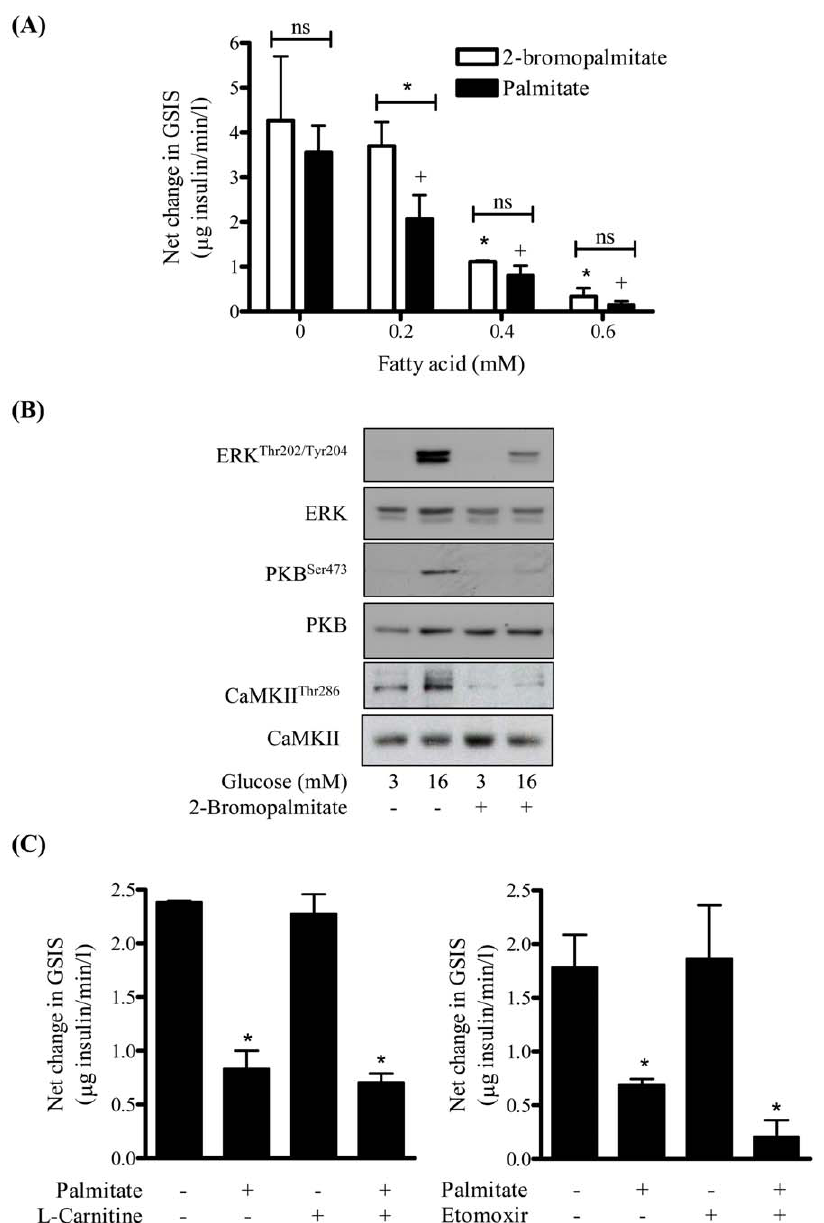
Figure 7. The repressive effects of palmitate on glucose-stimulated insulin secretion, PKB and ERK activation are not dependent upon fatty acid oxidation. (A) MIN6 b cells were incubated with varying concentrations of palmitate and 2-bromopalmitate (48 h) as indicated. Glucose (16 mM) was added for 1 h during serum starvation and the net change in glucose-stimulated insulin secretion assessed. (B) Cells were incubated in the absence or presence of 0.4 mM 2-bromopalmitate for 48 h and with glucose at the indicated concentration for 1 h. Cells were lysed and lysates immunoblotted for analysis of ERK Thr202/Tyr204 , PKB Ser473 , CaMKII Thr286 and total PKB, ERK and CaMKII. (C) Cells were incubated in the absence or presence of palmitate (0.4 mM) for 48 h and then after serum starvation cells were exposed to either L-carnitine (1 mM) or etomoxir (0.2 mM) for 2 h as indicated. Glucose (16 mM) was added during the final hour to induce GSIS and media removed for analysis of insulin content. Bars represent mean 6 SEM from 3 separate experiments and asterisks or a cross signify a significant difference from the untreated control values or between indicated bars (P , 0.05).